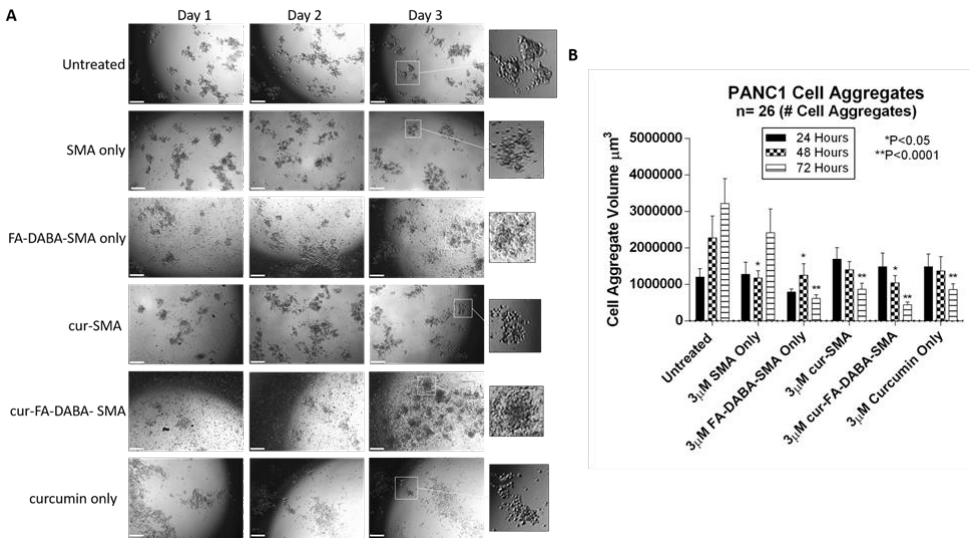
Figure 6. Changes in PANC- 1 cell aggregate volume following exposure to 3 µM empty and curcumin loaded SMA and FA-DABA-SMA and 3 µM curcumin only. ( A ) Phase contrast images at 4× objective of changes in spheroid volume over the course of three days following exposure to 3 µM empty and curcumin loaded SMA and FA-DABA- SMA and 3 µM curcumin only. A total of 10,000 cells were plated per well in a 96 well plate for a total of 7 days (4 days for cell aggregate formation followed by 3 days of treatment). ( B ) Cell aggregate volume was measured daily following treatment using V = (4/3) πr 3 where π = 3.1415 and r = average radius (µm). Radius was measured using a scale bar. Cell aggregate volume shown in the graph represents a cell aggregate volume ± standard error (error bars). Results were compared by a one-way ANOVA at 95% confidence using Fisher’s LSD test. The data presented in the graph are the combined results of two independent experiments that showed similar results. Notes: The control is represented by the spheroids that were untreated. Indicated p -values are a comparison between treated vs. untreated cells ( n = 26 cell aggregates). The image scale bar represents 100 µm. The insets are magnified 300%. Phase contrast images are not a complete representation of all the spheroids that were measured and plotted in the bar graph. Abbreviations: SMA, poly(styrene- alt -maleic anhydride); FA, folic acid; DABA, 2,4-diaminobutyric acid; Cur, curcumin; CA, cell aggregate.